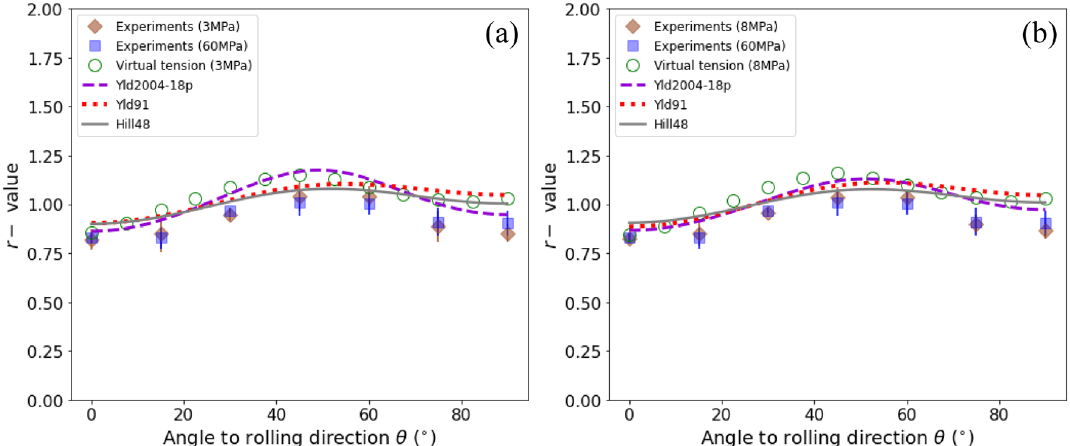
Figure 8. r -value versus θ of the DP980 sheet at deformation stages with the specific plastic work of ( a ) 3 MPa and ( b ) 8 MPa. The lines are the predicted results of the calibrated yield functions. The diamonds and squares represent experimental values at an interval of 15° from RD to TD and the open circles are the results obtained from virtual tests of uniaxial tension at an interval of 7.5° from RD to TD.